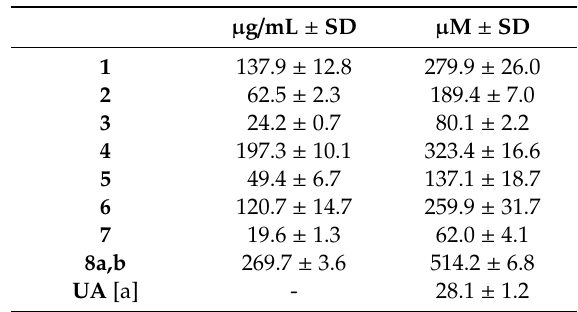
Table 3. Protein tyrosine phosphatase 1B (PTP-1B) inhibitory activity of compounds ( 1 – 8a , b ) from S. amarissima expressed as IC 50